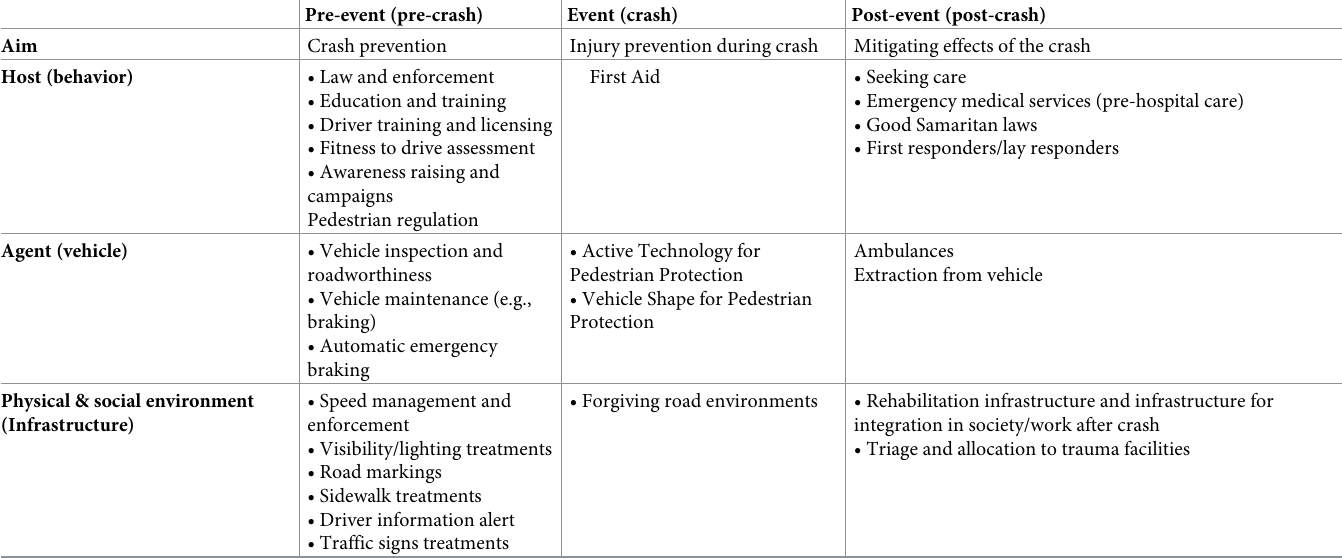
Table 1. Haddon Matrix applied to pedestrian-impacting